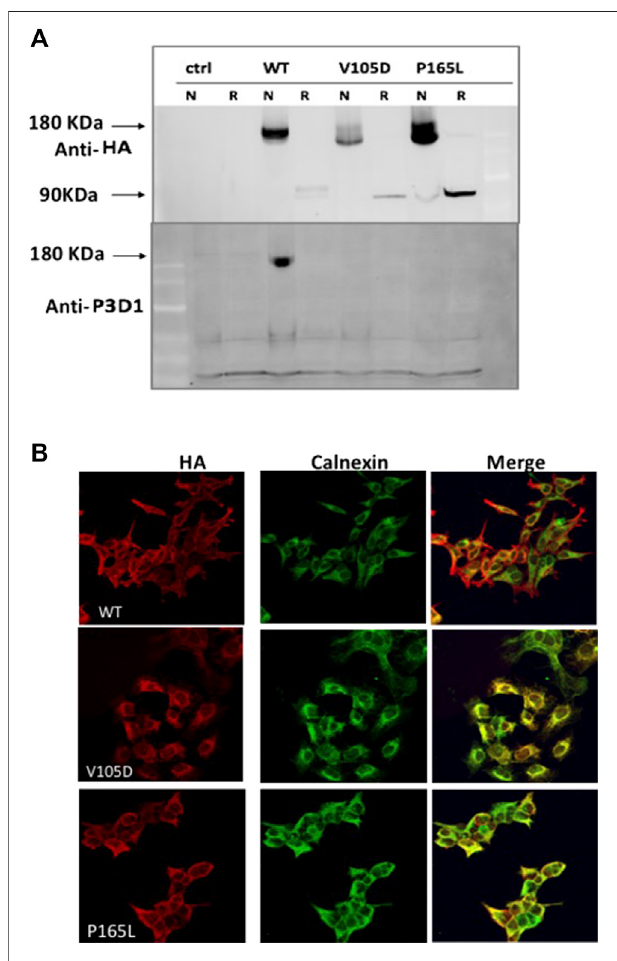
FIGURE 3 | Conformation distortion and subcellular colocalization of mutant variants P165L and V105D. (A) Binding of the conformation speci fi c P3D1 antibody to only the cell surface localized, non-reduced N-terminal epitope of ENG. Equal amount of cell lysate from stably transfected cells expressing the wild type or mutants were resolved under non-reducing (N) and reducing conditions and analyzed by both HA (top panel) and P3D1 (bottom panel) antibodies. (B) Immuno fl uorescence images showing colocalization of HA-tagged WT Endoglin and mutant variants P165L &V105D with ER marker (Calnexin) in stably transfected HEK-293